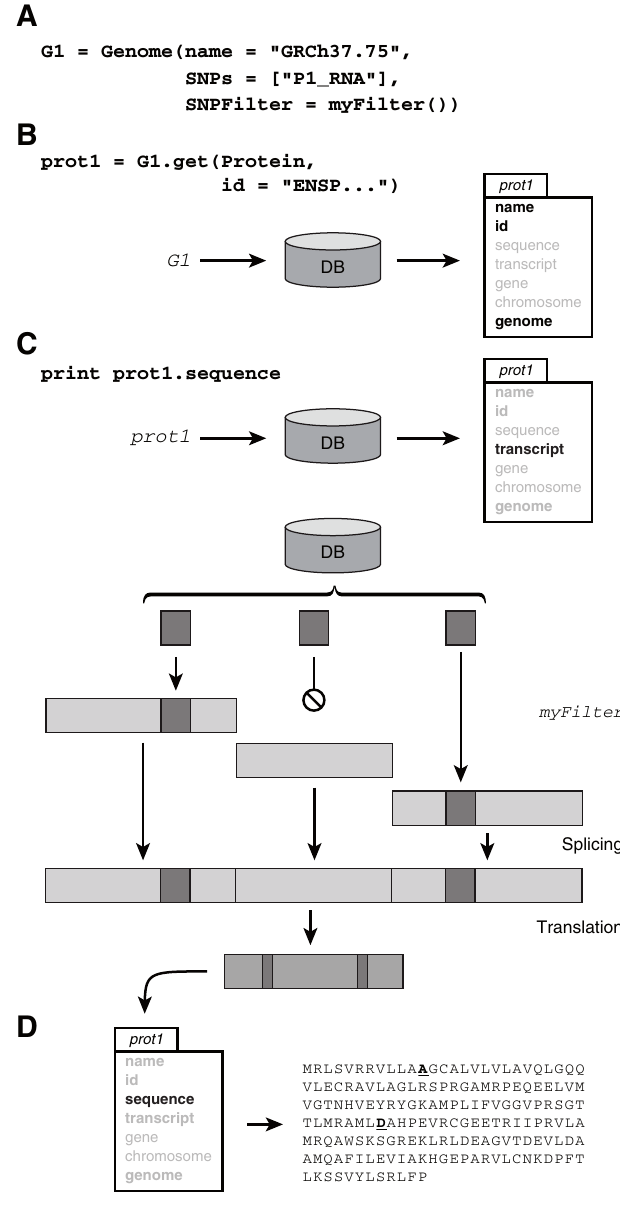
Figure 1. Extracting the subject-specific sequence of a protein. ( A ) Here we instantiate a personalized genome G1 by providing the Genome constructor with the name of a reference genome, a set of polymorphisms and a user defined SNP filter (for example a quality filter). ( B ) We then ask the get function of G1 to return a protein by id. The result is an object where only the fields in bold are fully loaded, other fields will be automatically loaded when and if accessed. ( C ) Asking for the currently unloaded sequence of the protein triggers the following sequence of events. The transcript, as well as the exons that encode for it, and any polymorphisms in their regions are loaded. The polymorphisms are filtered according to the filter provided to the genome constructor (for example, according to sequencing quality) and inserted at their corresponding locations. The exons are then assembled into the transcript sequence and the sequence is translated. ( D ) The sequence as well as the transcript are now fully loaded and the sequence of the precision protein is